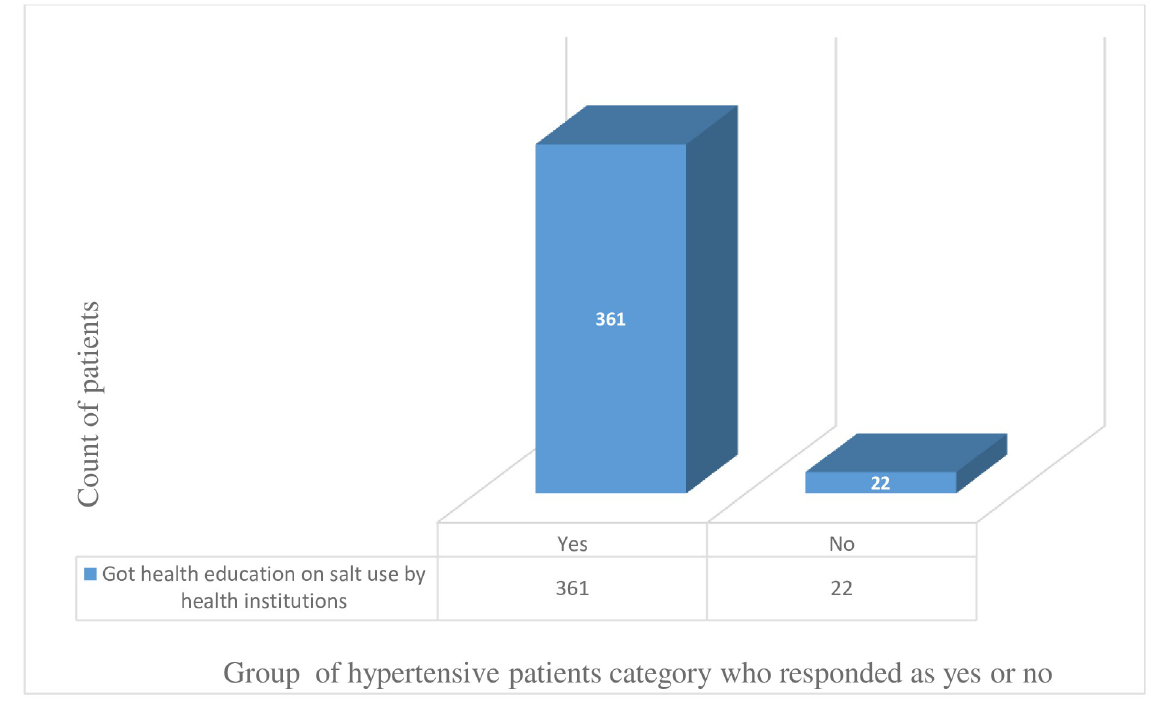
Fig 1. The number of patients who attended health education on salt use in health institutions.